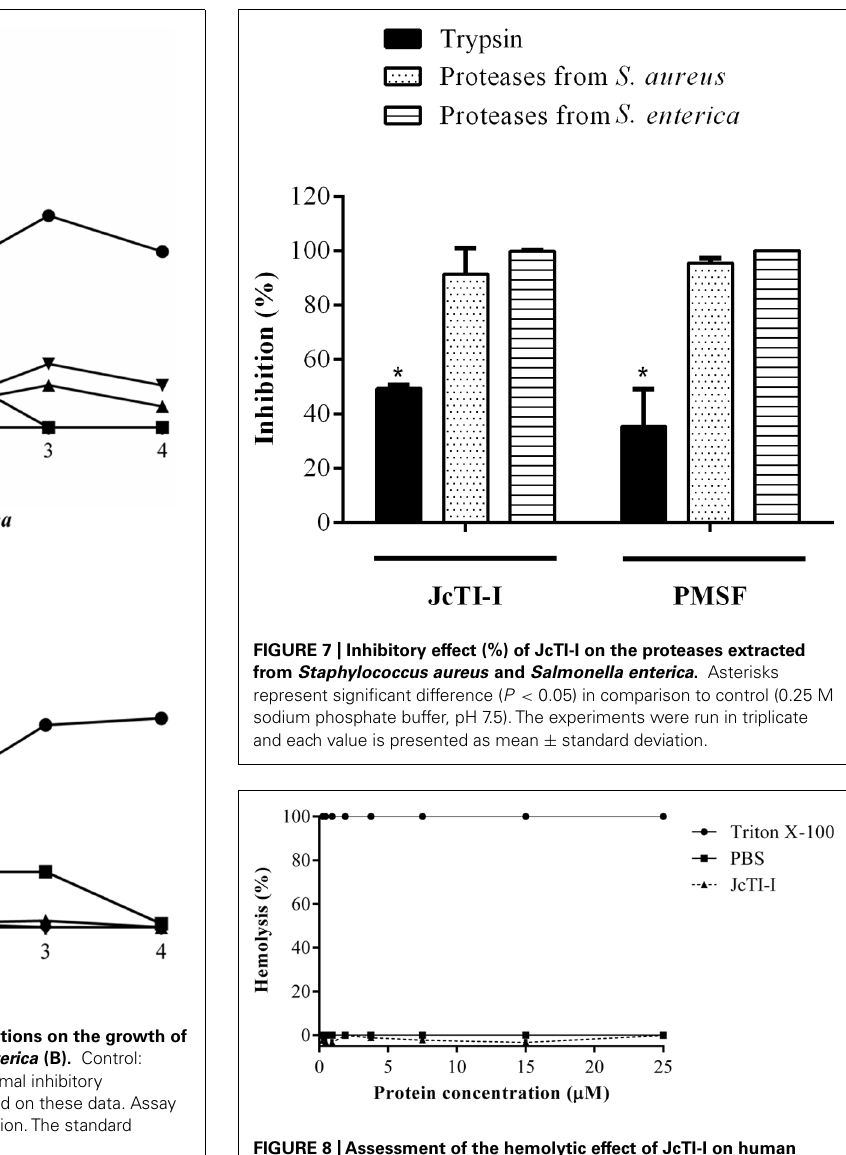
FIGURE 8 |Assessment of the hemolytic effect of JcTI-I on human erythrocytes. A suspension of washed human erythrocytes was incubated with various concentrations of JcTI-I (- (cid:2) -).Values (OD 540 ) were normalized against 100% lysed erythrocytes (0.1%Triton X-100) (- • -). Control was the red cells incubated with 0.05 M PBS, pH 7.4 (- (cid:3) -). Each point represents the mean of three estimates.The standard deviation was less than